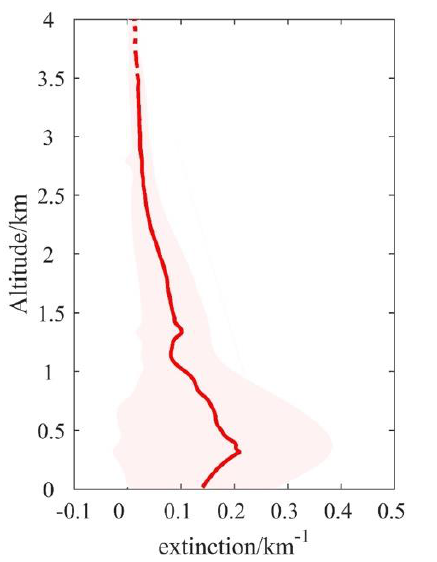
Figure 1. The mean extinction coefficients of aerosol in Oct. 6, 2017. The lines connected by red dots in the figure represent the average retrieved extinction coefficients, while the light red shadow indicates the standard deviation. The horizontal axis represents extinction coefficients and the vertical axis represents the attitude.